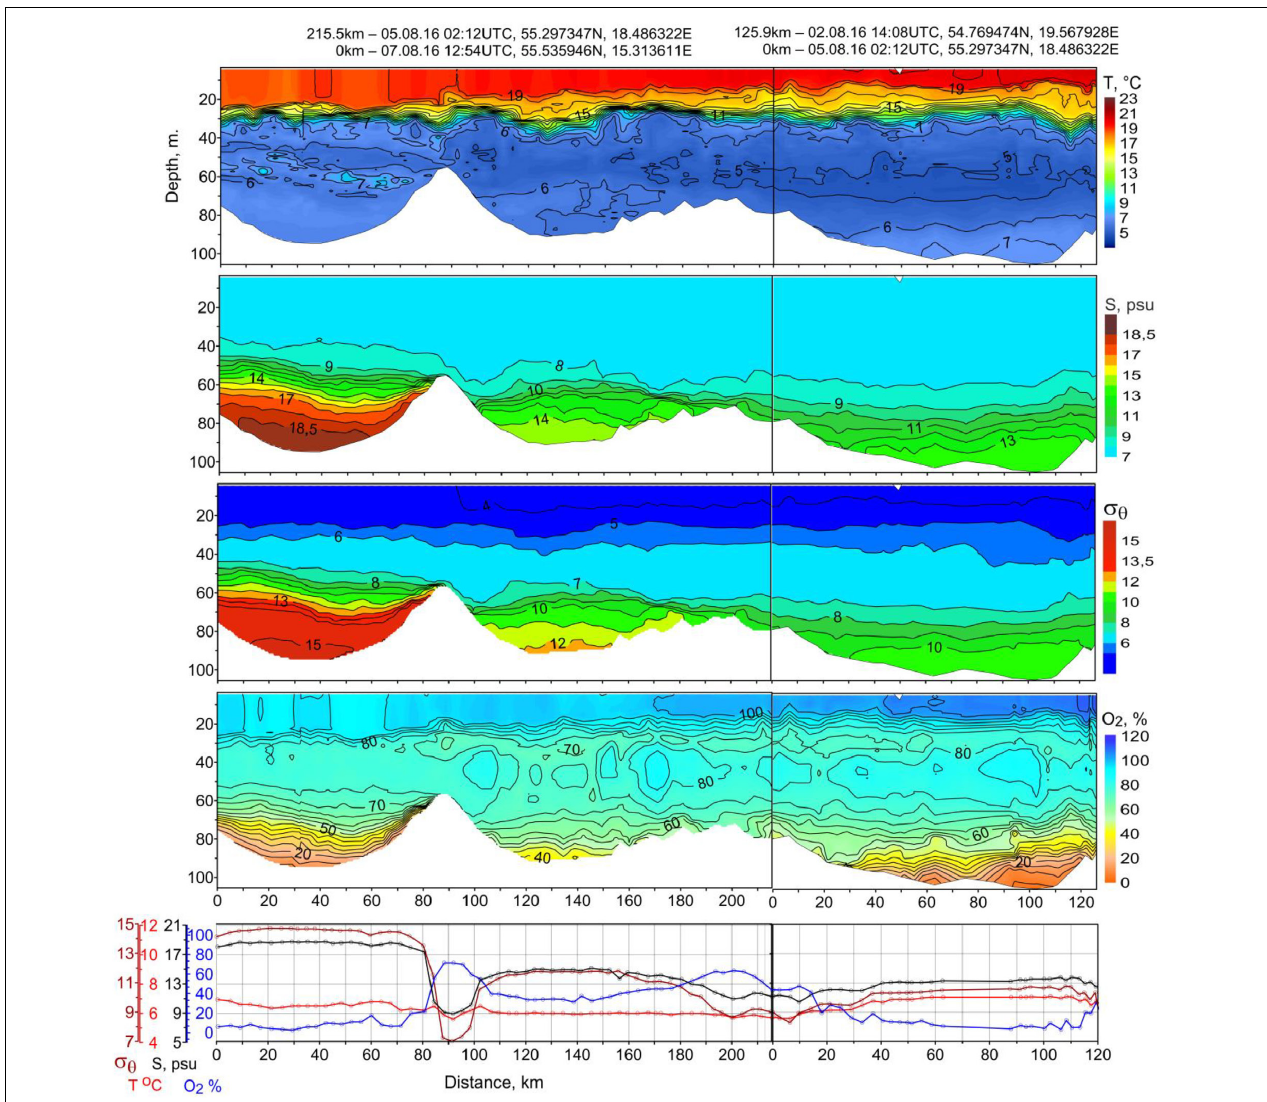
FIGURE 6 | Distributions of temperature T ( ◦ C), salinity S (psu), density σ θ , and oxygen saturation O 2 (%) in the southern Baltic for the 1st survey (August 2016); bottom panels demonstrate graphs of the same parameters in the bottom